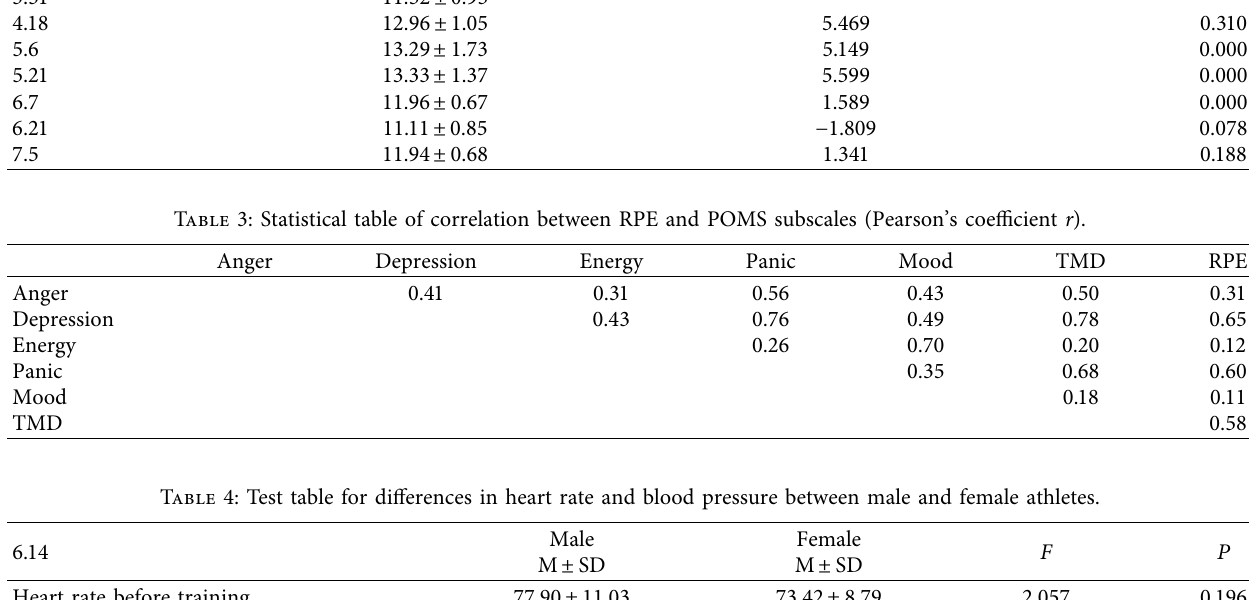
Table 4: Test table for differences in heart rate and blood pressure between male and female athletes.